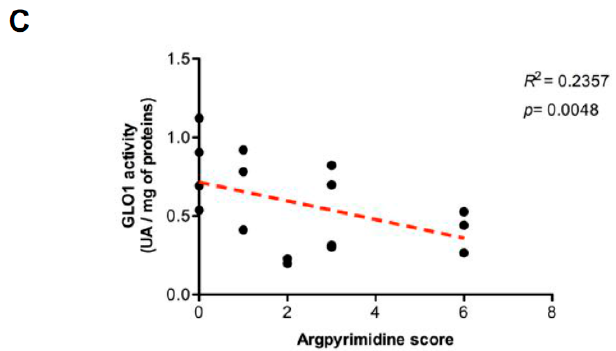
Figure 3. 18 F-FDG PET activity and argpyrimidine accumulation in CRC patients. ( A ) SUVmax is significantly higher in tumors with high dicarbonyl stress. Each dot represents one case and bars represent mean ± SEM. ( p = 0.0105, Mann–Whitney test); ( B ) GLO1 activity and expression were evaluated in stage 1 ( n = 3), stage 2 ( n = 5), stage 3 ( n = 4) and stage 4 ( n = 5) colorectal cancer patients. β - Actin is used as loading control. Right panel, GLO1 activity is significantly higher in low stage tumors compared with high stage ones. Average of three technical replicates ± SEM is shown (Neuwman–Keul Tests, * p < 0.05); ( C ) The correlation analysis performed between argpyrimidine immunostaining score and GLO1 activity evaluated on 17 CRC patients demonstrated a significant inverse correlation between these two parameters (Spearman rank correlation test).